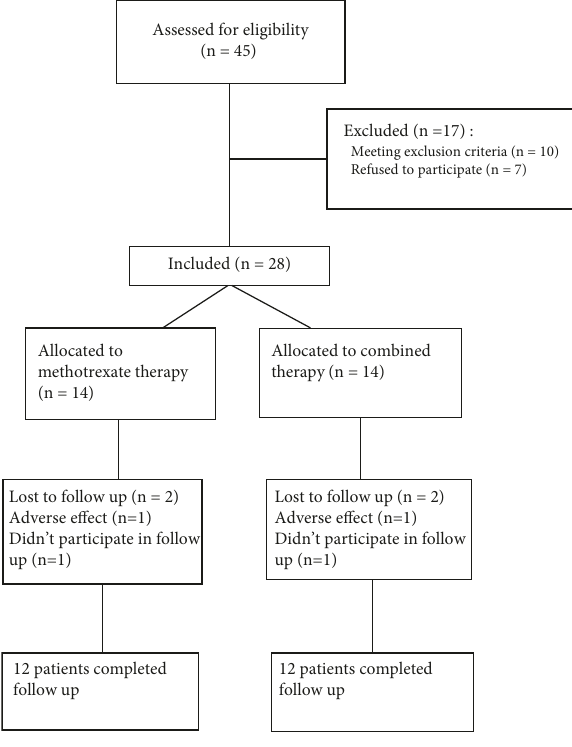
Figure 1: The study